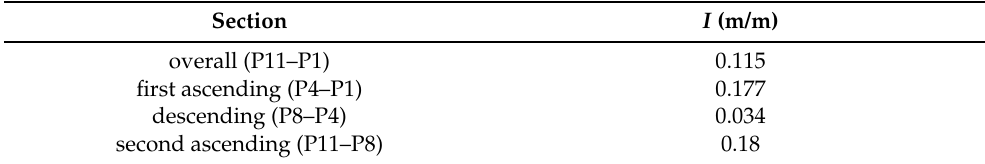
Table 3. Hydraulic gradient during mixture transport.